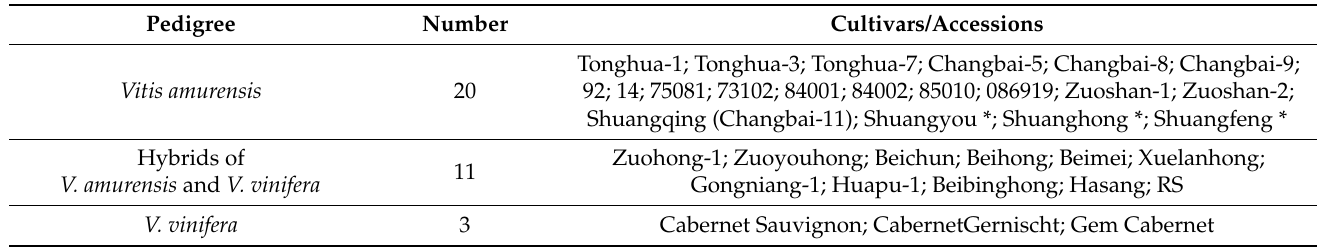
Table 1. Grape cultivars/accessions collected in this